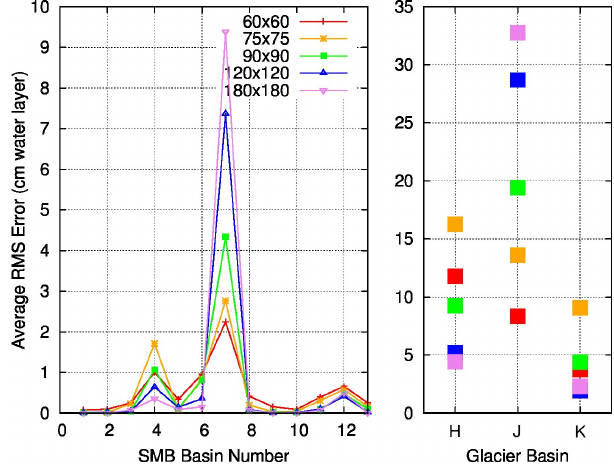
Figure 6. Average RMS difference from truth per basin for the SMB-only simulations, for data of increasing maximum degree, in SMB basins and glacial basins. Yearly windowing applied.